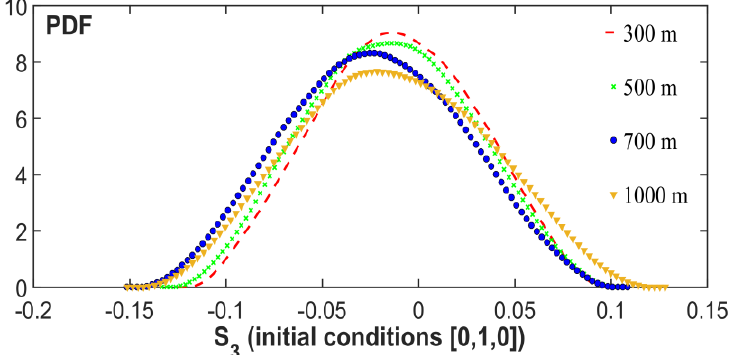
Figure 4. Mean S 3 pdf for different distances.